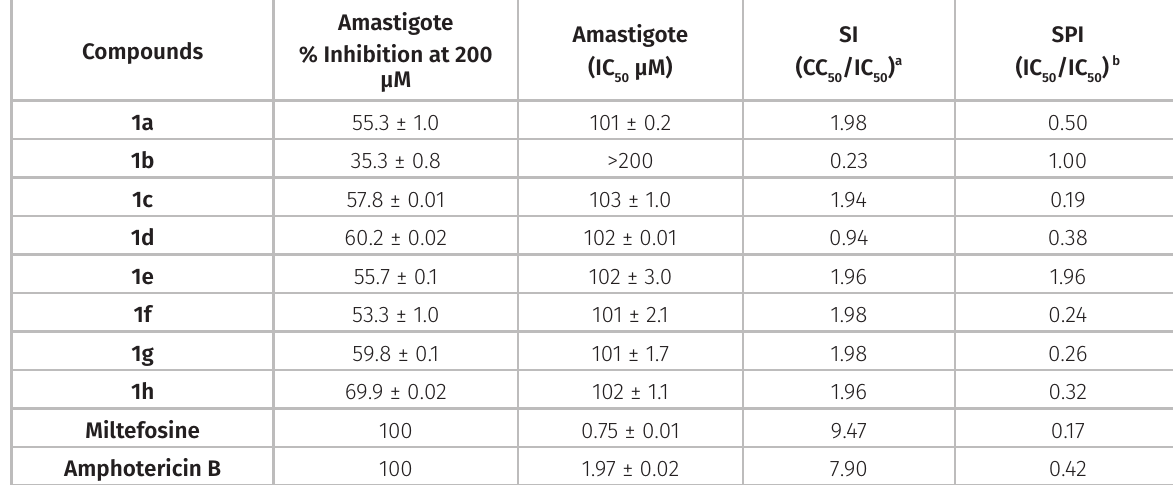
Table IV. Results of anti-amastigote activity promoted by the compounds, percentage of inhibition of parasite growth at a concentration of 200µM, IC values, selectivity and specificity 50